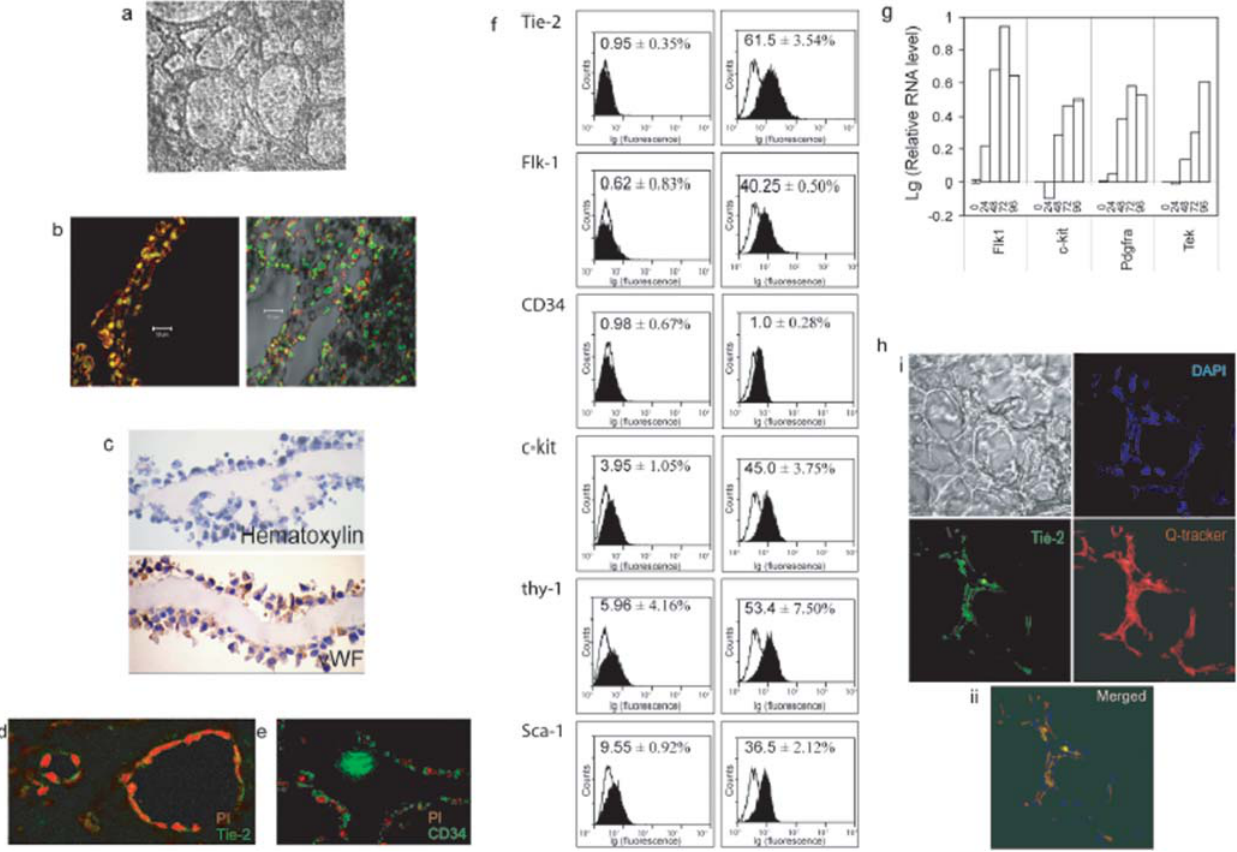
Figure 3. Differentiation of E-RoSH cells. In vitro differentiation a) Morphology of E-RoSH2.1 cell culture two weeks after plating E-RoSH2.1 cells on matrigel coated plate, b) The patent E-RoSH2.1 derived tubular structures were labeled with CFDA, a cytoplasmic green fluorescent dye (Molecular Probe, Eugene, OR) and propidium iodide, and viewed by confocal microscopy (left panel). The tubular structures were incubated with acetylated red fluoresecent diI-labelled LDL (Molecular Probe, Eugene, OR) for 24 hours and counterstained with SYTOX Green TM , a green fluorescent nuclear dye (Molecular Probe, Eugene, OR) before analysis by confocal microscopy (right panel). c–e) Immunoreactivity for vWF, Tie-2 and CD34 on sections of E- RoSH2.1 derived tubular structures. vWF immunoreactivity was visualized using HRP-based detection system. Brown precipitates indicate positive staining. The nuclei were stained with Mayer’s hematoxylin. CD34 and Tie-2 immunoreactivities were detected using secondary antibodies conjugated with FITC. Nuclei were counterstained with PI. f) Flow cytometry analysis of E-RoSH2.1 cells for endothelial markers before (right panels) and 60 hours after (left panels) induction of differentiation by plating cells on matrigel. Nonspecific fluorescence was determined by incubation of similar cell aliquots with isotype-matched mouse monoclonal antibodies or with secondary antibody alone. g) Gene expression during in vitro differentiation of E-RoSH2.1 cells on matrigel as measured by quantitative RT-PCR analysis. Relative gene expression is normalized against that at time 0 and expressed as a logarithmic function. h) In vivo differentiation. 1 6 10 5 E-RoSH2.1 cells labeled with Qdot H nanocrystals (655 nm emission) were injected into a ESC-derived teratoma that was induced in SCID mice. Three days later, the mice were euthanized and the tumors were removed. The tumors were fixed in 4% paraformaldehyde and cryosectioned at 20 m m thickness. The sections were assayed for Tie-2 immunoreactivity using rabbit anti-Tie-2 followed by FITC-conjugated goat anti-rabbit antibody, and counterstained with DAPI. i. A typical section of a capillary plexus in the teratoma as viewed by phase contrast microscopy ( top left panel ), stained with DAPI, a nuclear stain ( top right panel ), stained with using rabbit anti- Tie-2 ( bottom left panel ), and cells labelled with Qdot ( bottom right panel ). ii. Merging of the three fluorescent stains. Yellow fluorescence indicates co- localisation of Qdot and FITC-conjugated